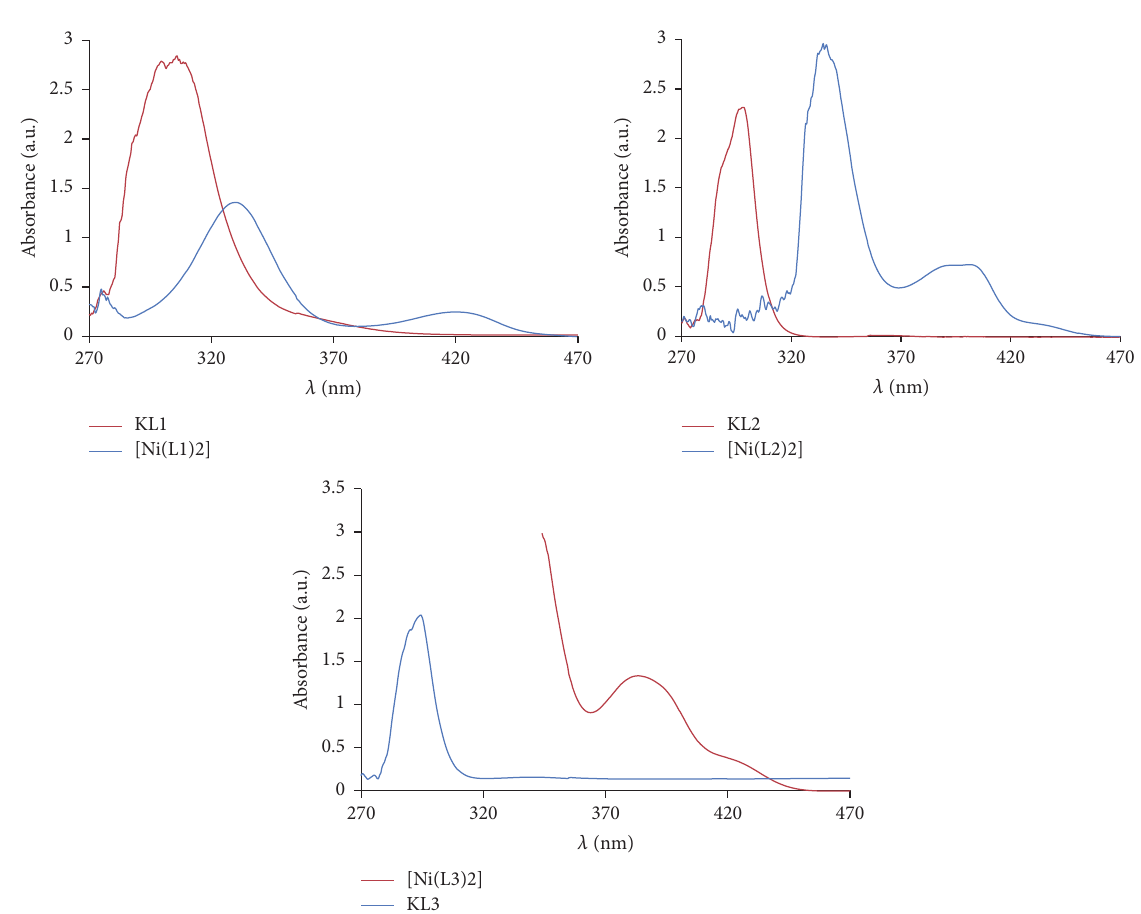
of the emission peaks as shown in Figure 4 could be ascribed to size distributions